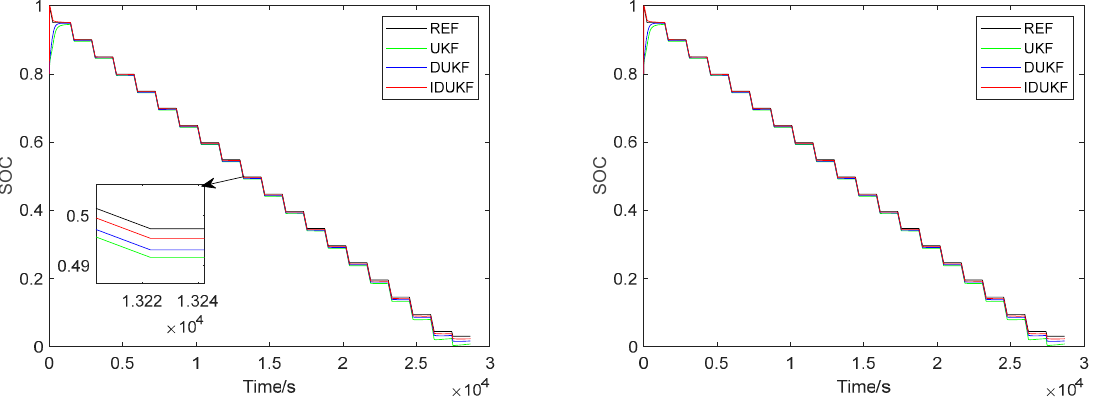
Figure 14. SOC estimation in the CCPC tests.